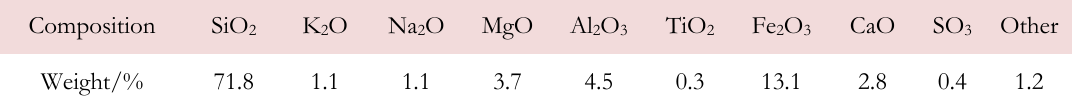
Table 1: Chemical compositions of the iron tailing sand.